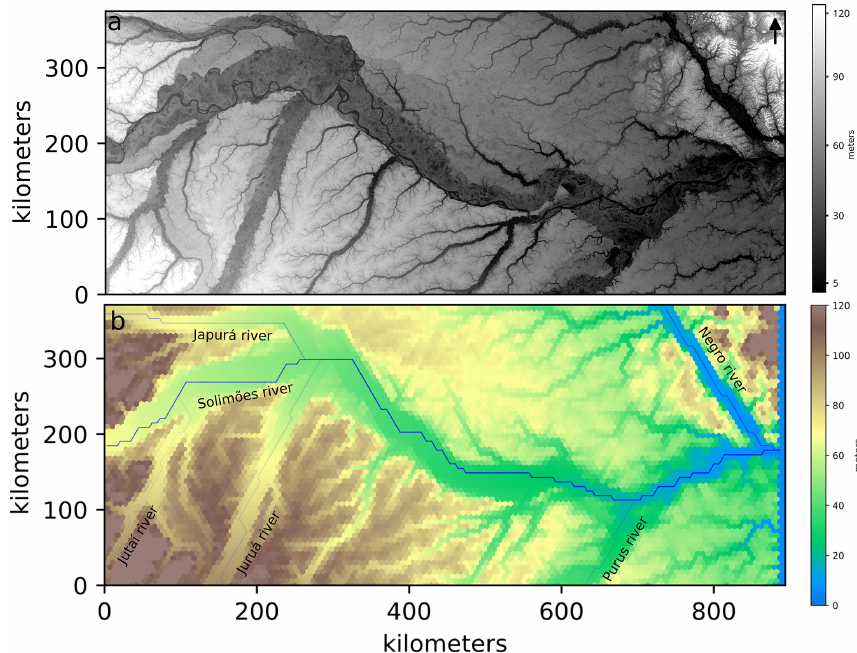
Figure 3. (a) Shuttle Radar Topography Mission (SRTM) digital elevation model of central Amazonia, with a resolution of 90m at the Equator. (b) Initial topography and configuration of the numerical simulations. The blue lines represent the channels and the thickness of the line is proportional to the discharge of the corresponding stream.